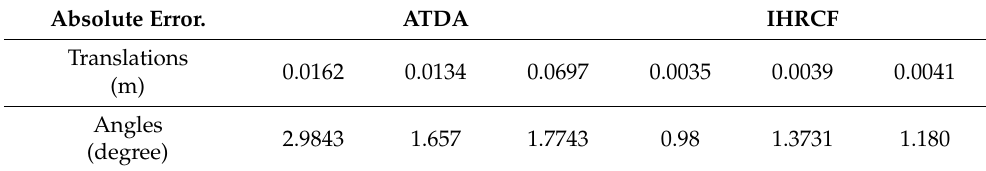
Table 2. Mean absolute error comparison of AprilTag and IHRCEFcalibration algorithms. Absolute Error. ATDA